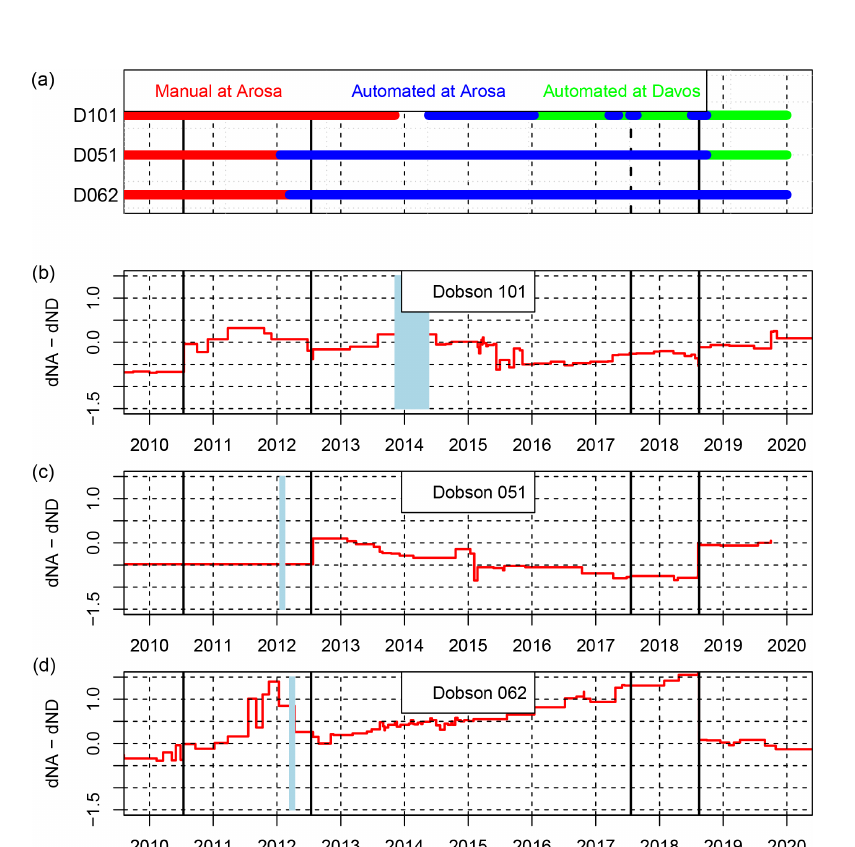
Figure 2. (a) Historical changes of the Dobson operation as well as of the instrument locations. (b–d) Time series 2010–2020 of the lamp corrections δN A – δN D for the three LKO Dobson instruments. The vertical yellow bars denote the intercomparisons with the European regional standard. The blue bands mark the unavailability of each Dobson instrument during the process of